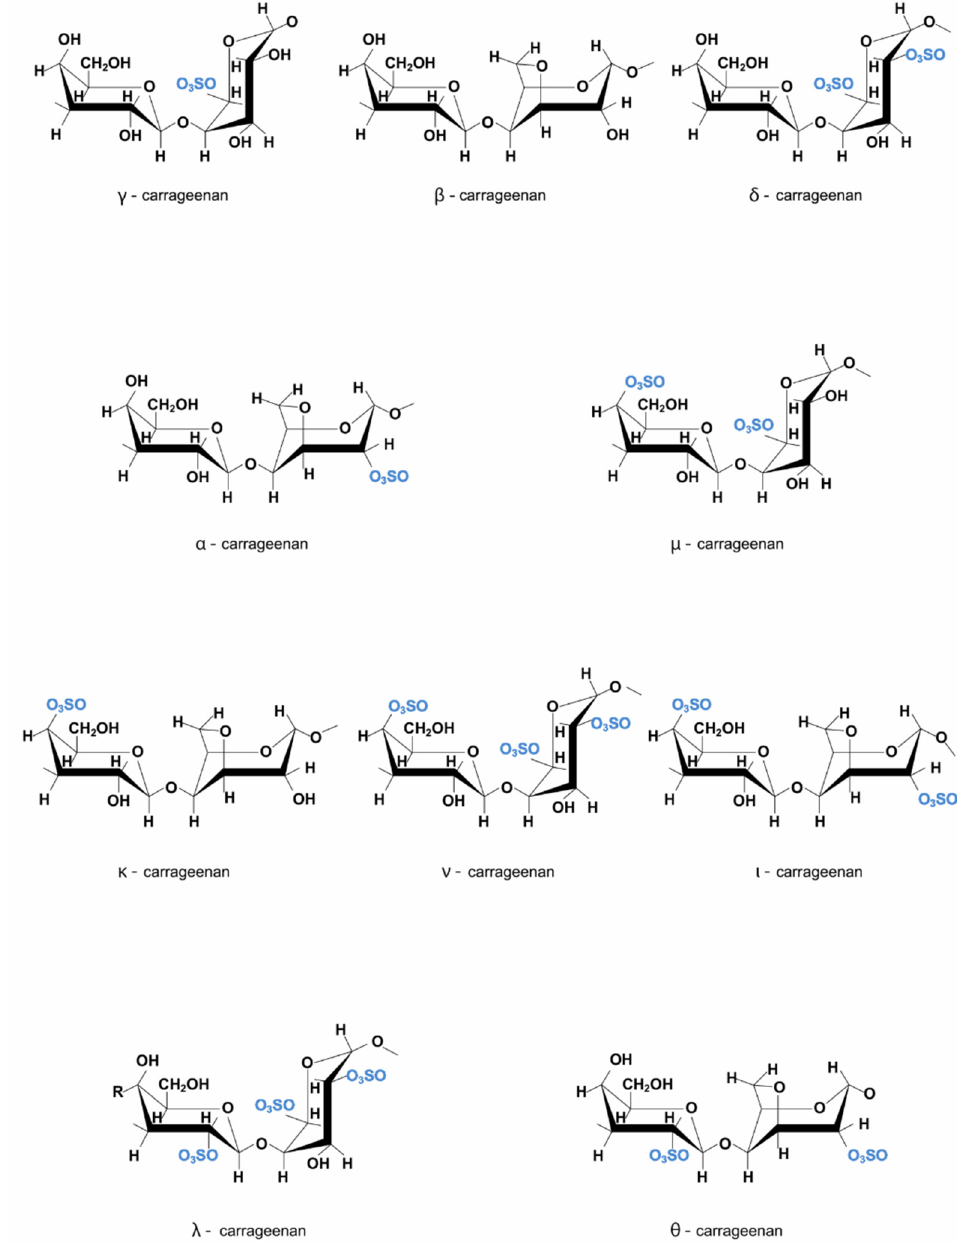
Figure 3. Carrageenan structure.